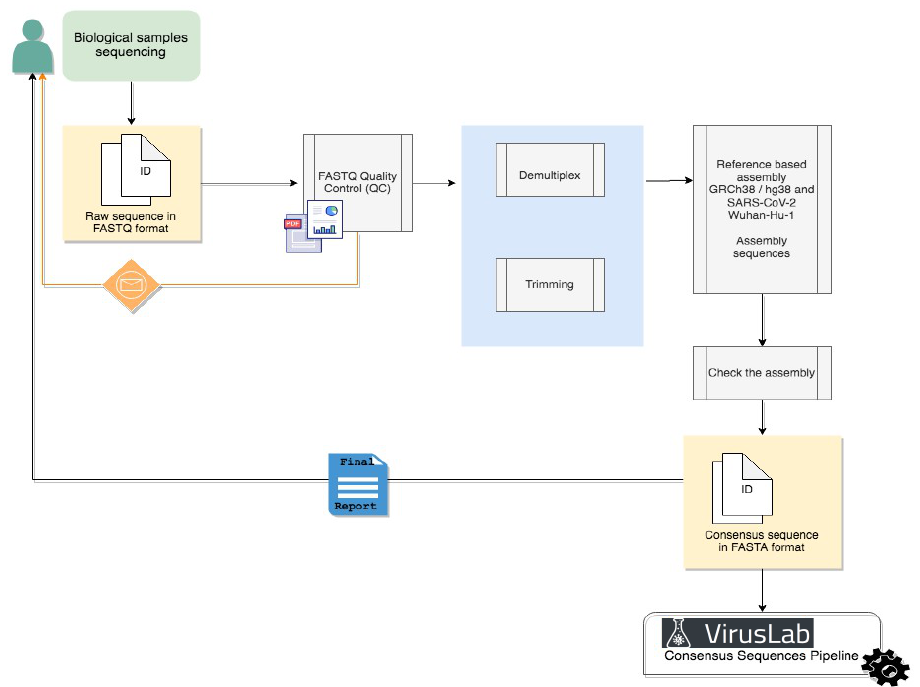
Figure 2. Raw sequence analysis